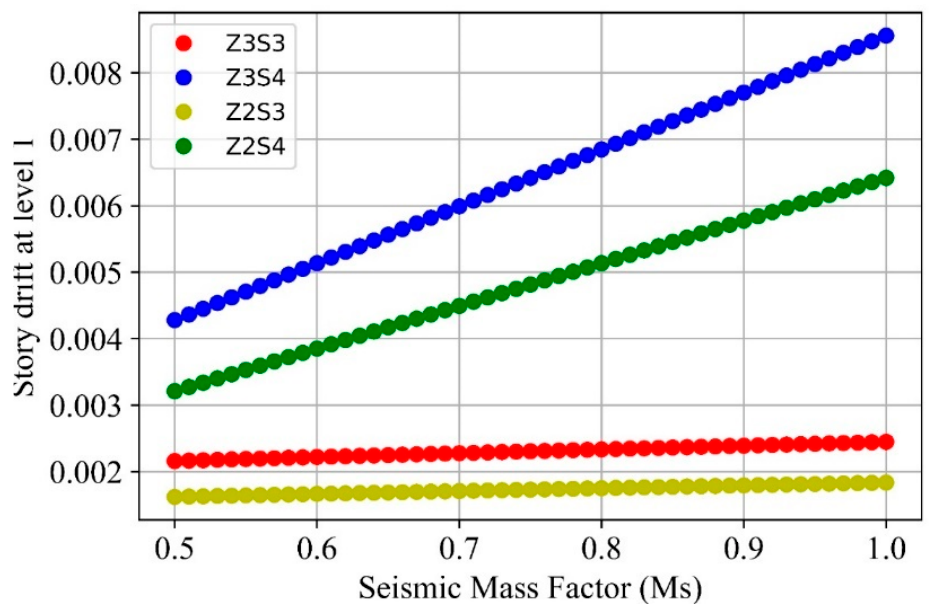
Figure 16. Variation of seismic mass factor (Ms) vs. drift at level 1.